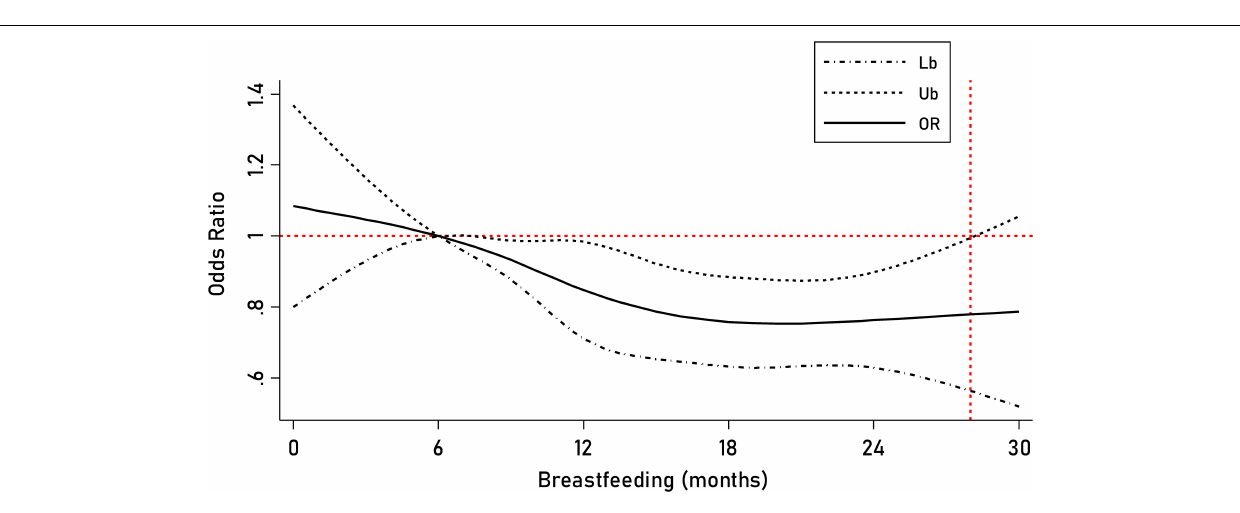
FIGURE 2 | Prediction of the breastfeeding duration for C-ASQ-defined ADHD susceptibility. The solid line represents the odd ratio (OR) for C-ASQ-defined ADHD susceptibility as the breastfeeding duration increases, and the black dashed line represents the corresponding 95% confident interval of the odd